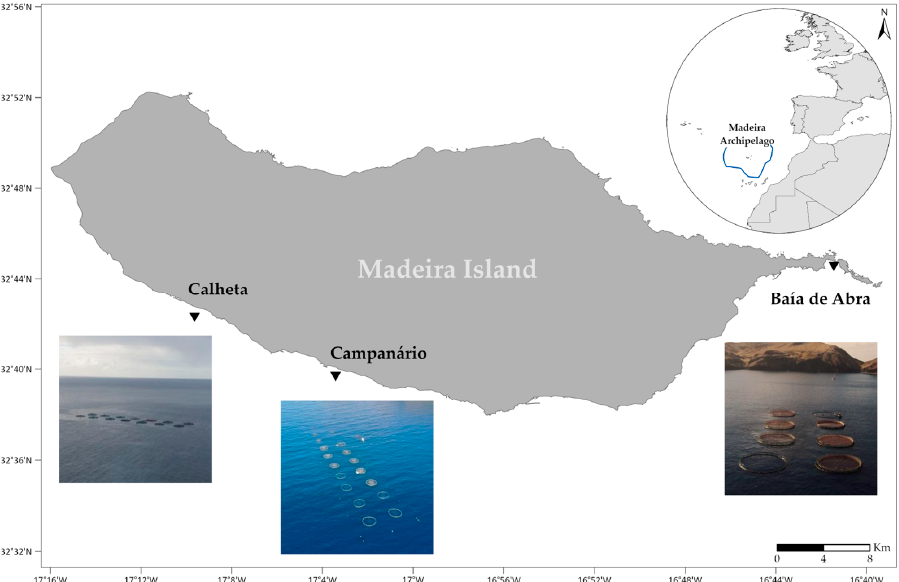
Figure 1. Geographic setting and map with locations of the three existing aquaculture fish farms in Madeira Island.